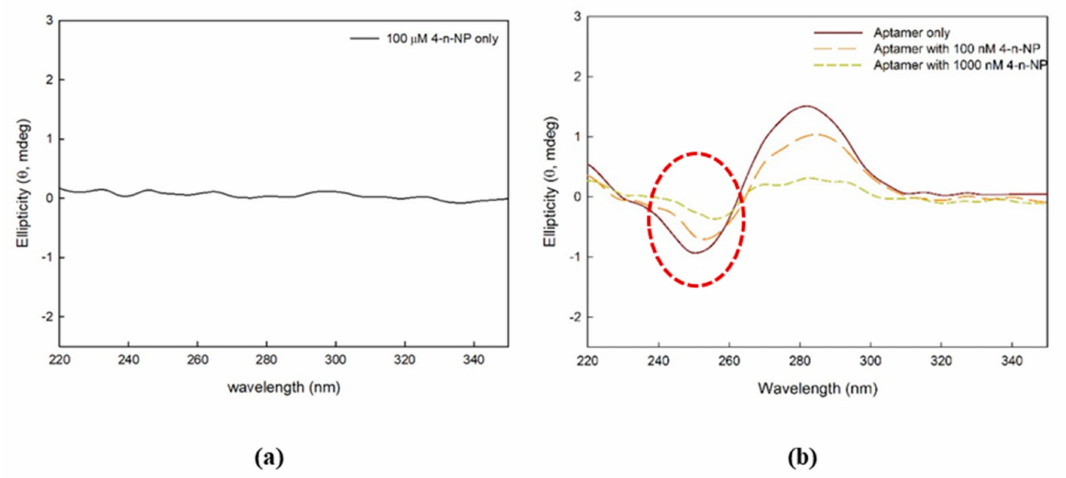
Figure 5. Ellipticity of ( a ) 4-n-NP only and ( b ) aptamer with varying concentrations of 4-n-NP. The red dotted circle in Figure 5b indicate interaction of 4-n-NP with the aptamer changed the CD spectrum at ~250 nm.